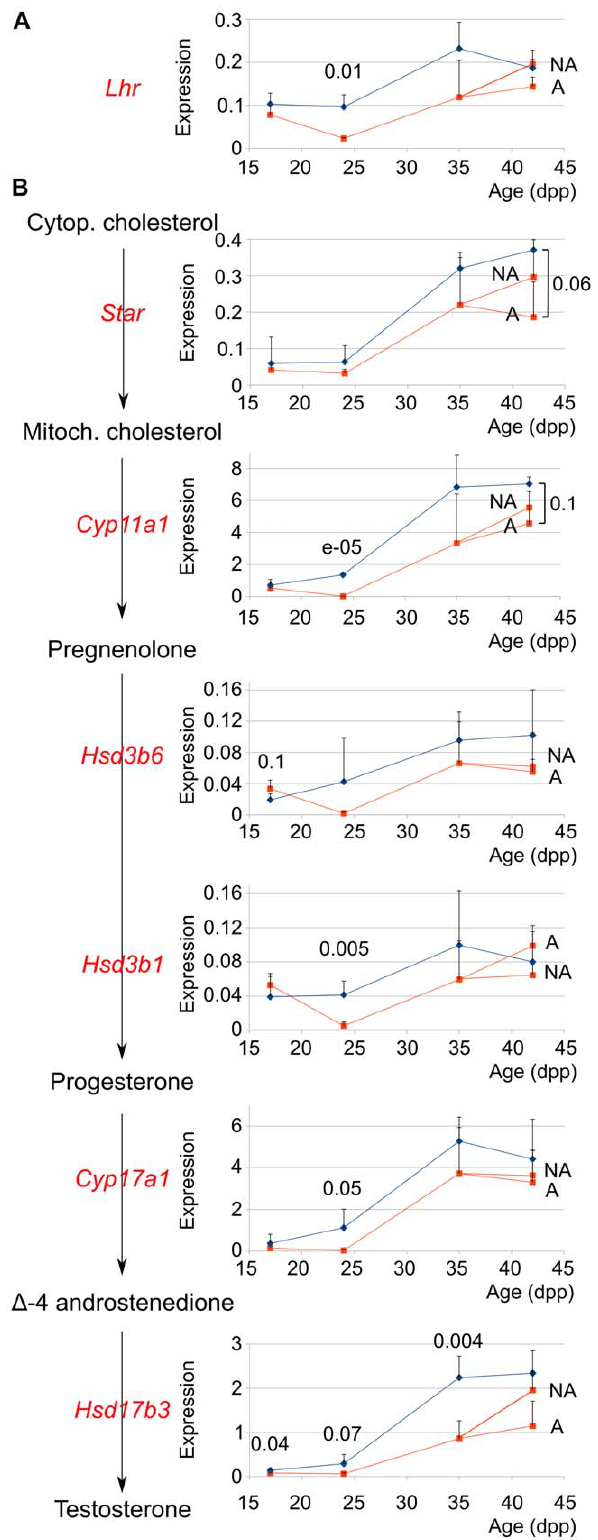
Figure 4. The expression of Leydig cells markers is delayed in prepubertal Celf1 2 / 2 mice. We quantified by real-time RT-PCR the relative amounts of the indicated mRNAs in + / + (blue diamonds) and 2 / 2 (orange squares) testes at the indicated prepubertal ages. NA (not affected) and A (affected) refer to 42 dpp 2 / 2 mice with and